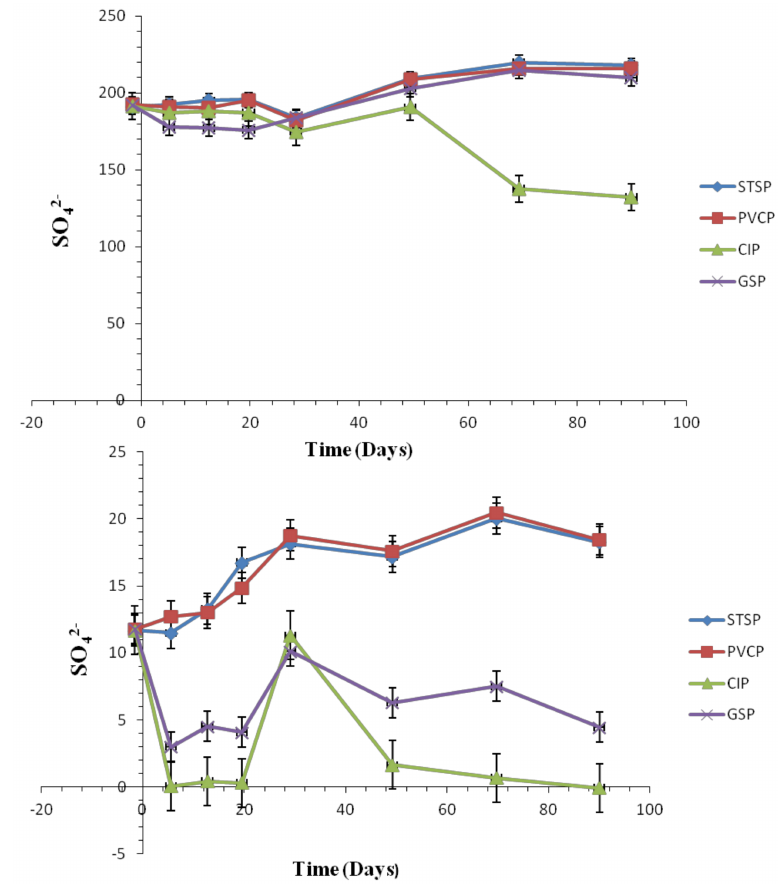
Figure 8. Variations of sulfate concentration in RW and TW in stainless steel, polyvinyl chloride, cast iron, and galvanized steel pipes over time with standard